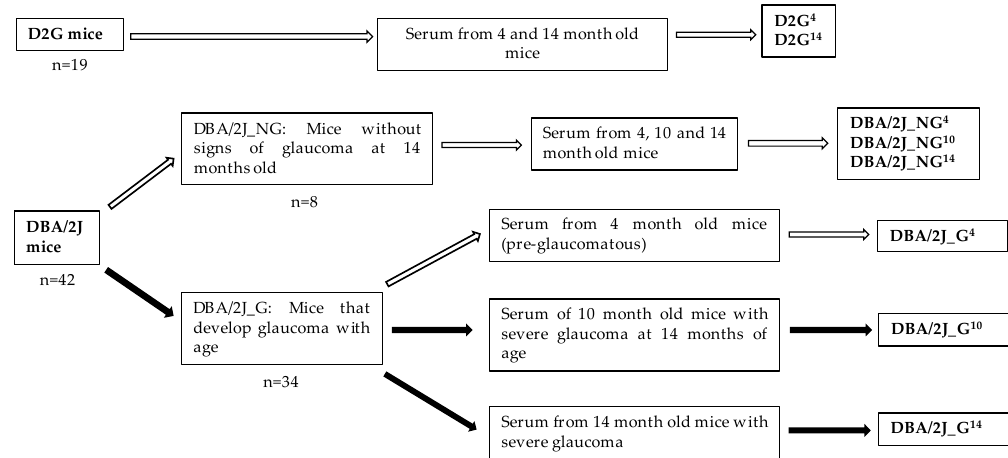
Figure 2. Experimental groups. Control groups: D2G 4 , D2G 14 , DBA/2J_NG 4 , DBA/2J_NG 10 , and DBA/2J_NG 14 . Glaucoma groups: DBA/2J_G 4 , DBA/2J_G 10 , DBA/2J_G 14 . White arrows indicate samples of non-glaucomatous mice. Black arrows indicate samples of glaucomatous mice.